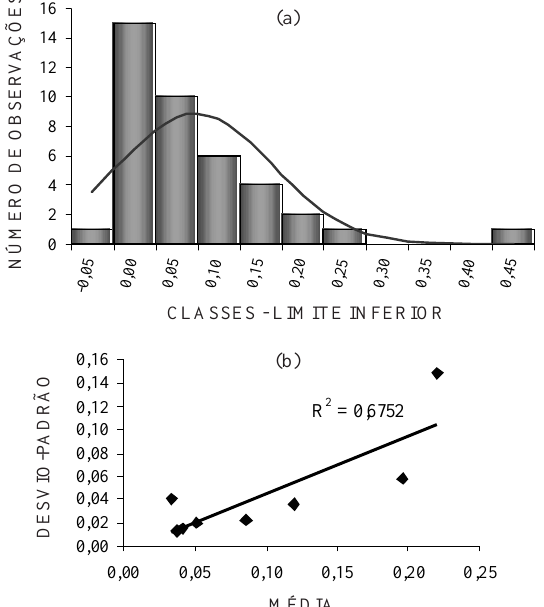
Figura 1. Distribuição de freqüências (a) e desvio- padrão de acordo com a média (b) para subamostras de 5 observações para a taxa de infiltração após 3,5 min.